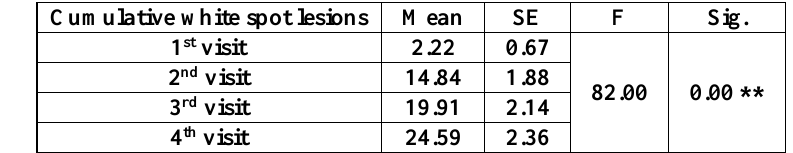
Table 1: Mean and standard deviation values of white spot lesions during four time